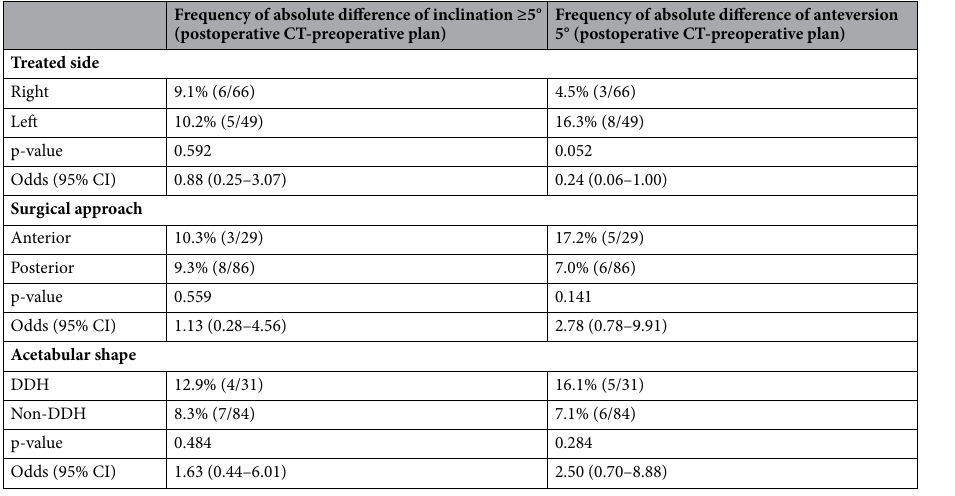
Table 3. Results of cup angles accuracy.